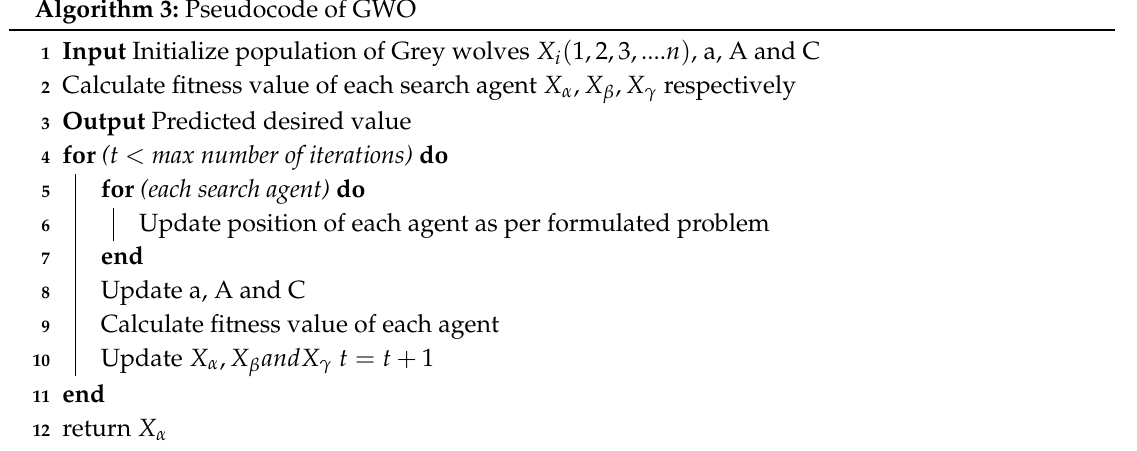
Algorithm 3: Pseudocode of